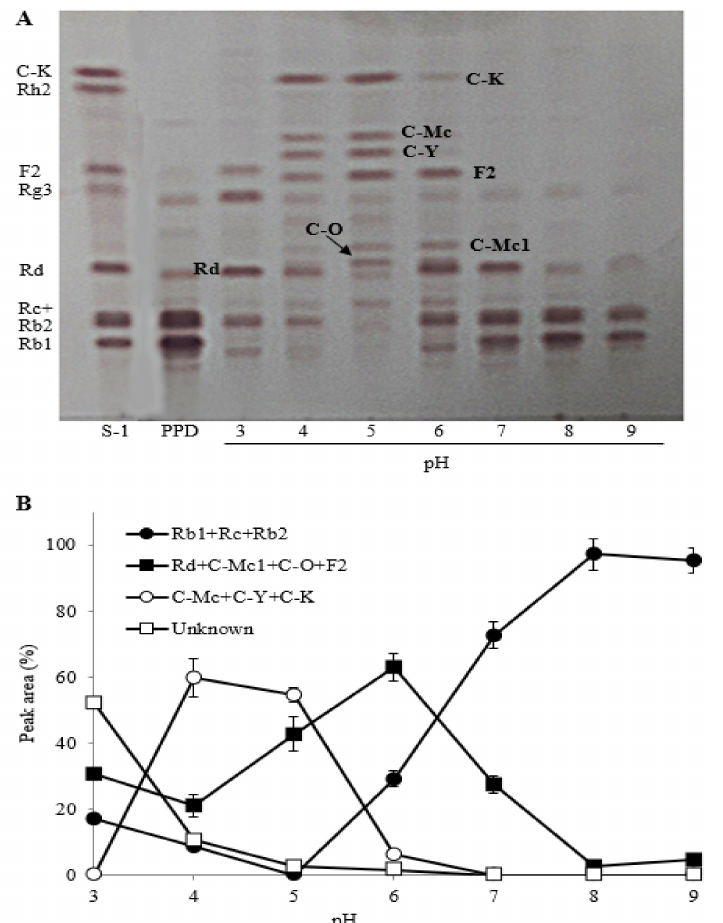
Figure 4. Effect of reaction pH on the biotransformation of PPDG-F by FFEP. ( A ) TLC; ( B ) relative peak area percentage (%) by HPLC.